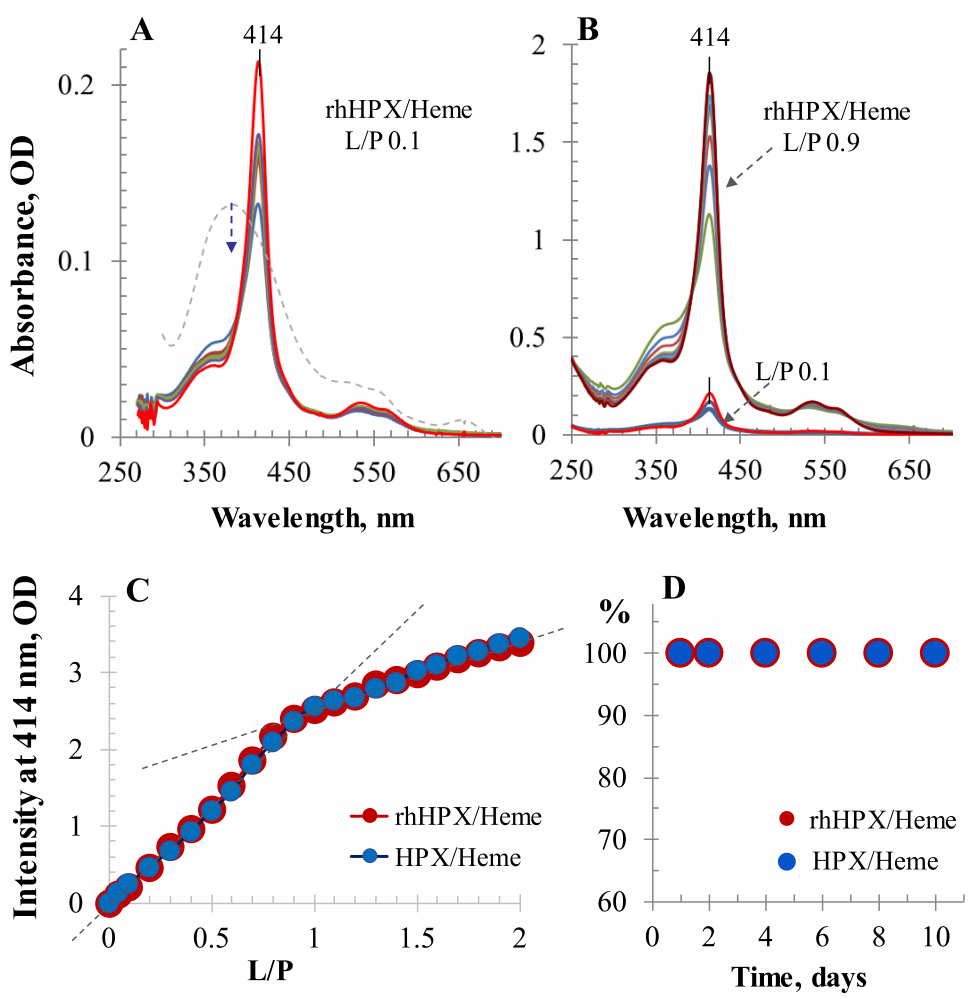
Figure 2. UV/Vis data for heme binding to rhHPX and plasma HPX. ( A ) Dynamics of heme binding to rhHPX at ligand-to-protein ratio (L/P) 0.1 monitored during 10 min (gray dotted trace shows heme in phosphate buffer saline (PBS) alone). ( B ) Time-course UV/Vis spectra of rhHPX/Heme at L/P 0.9 collected during 10 min (overlaid with A). ( C ) The absorbance intensities at 414 nm of heme complexes with rhHPX and plasma HPX plotted vs. L/P. Protein concentration for both rhHPX and plasma HPX was 18 µ M in PBS. All UV/Vis data were collected in differential form by measuring spectra of mixed samples against respective 18 µ M protein in a 10 mm path length cuvette. The samples with the absorbance intensity at 414 nm exceeding the instrument absorbance accuracy limit (higher than 2.4 OD) were measured in a 5 mm pathlength cuvette. ( D ) Monitoring stability of the heme complexes with HPX and rhHPX by the Soret band intensity (shown for samples with L/P